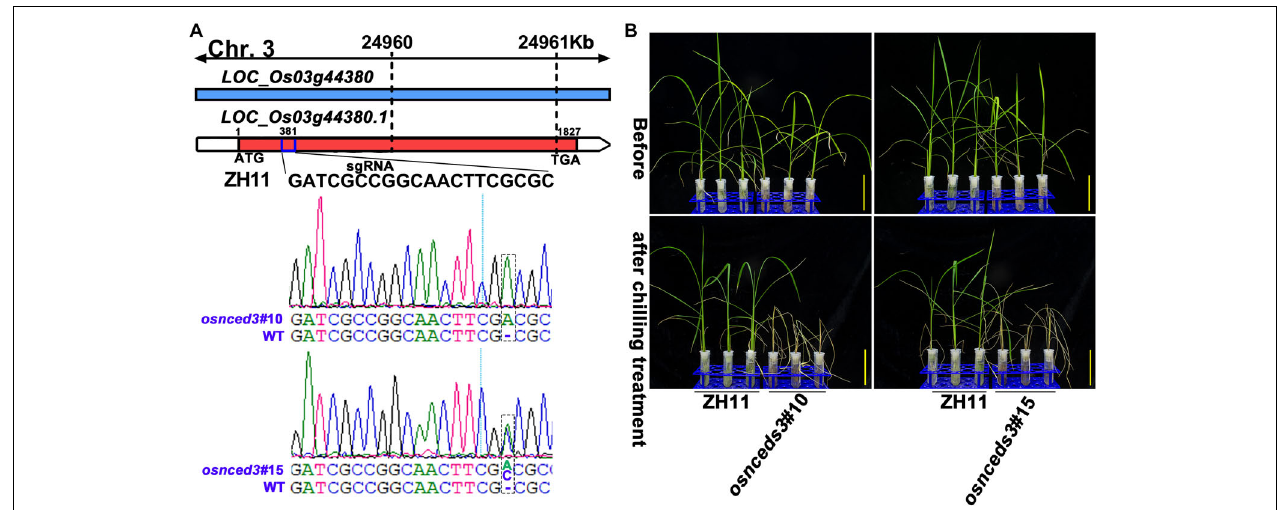
FIGURE 7 | CRISPR/Cas9-edited OsNCED3 gene and the chilling stress phenotype of CRISPR/Cas9-edited lines. (A) Targeted site designed in the coding sequence of OsNCED3 and the sequences of target site in two knockout lines. (B) The chilling stress phenotype of OsNCED3 CRISPR/Cas9-edited knockout lines. Scar bar = 5